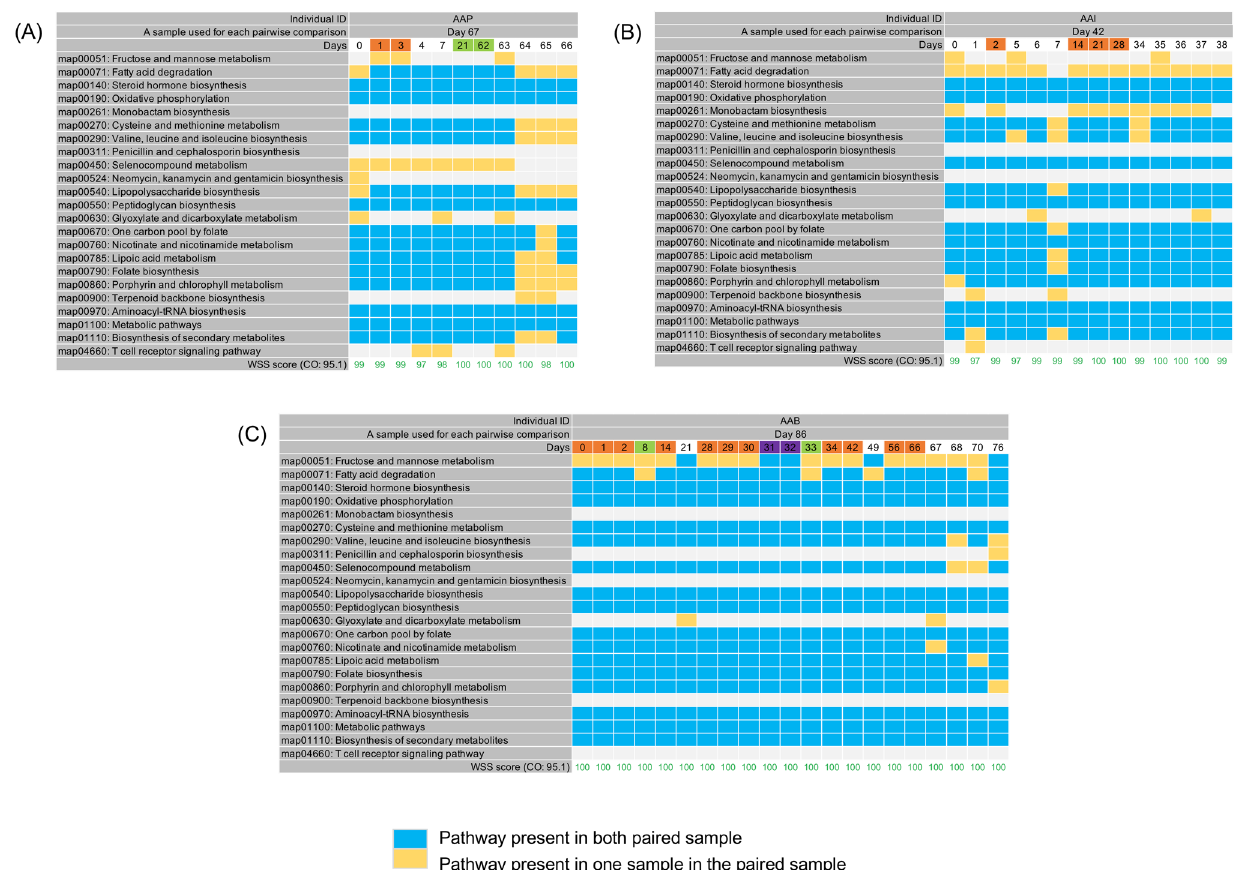
Figure 3. Shared PKS results from high density sampling of three healthy individuals. A total of 23 KEGG pathways were used to observe a pattern of presence/absence of KEGG metabolic pathways for B. vulgatus and the presence or absence of each KEGG pathway was examined by comparing each individual’s last day sample to every possible pair of the same individual’s samples. All samples from the three individuals, including ( A ) AAP, ( B ) AAI, and ( C ) AAB were previously collected by Fukuyama et al. 16 . The shared PKS result per individual was depicted by different colored boxes. Each column in the table represents individual ID, a sample used for each pairwise comparison, and days (Detailed sample information shown in Supplementary Table